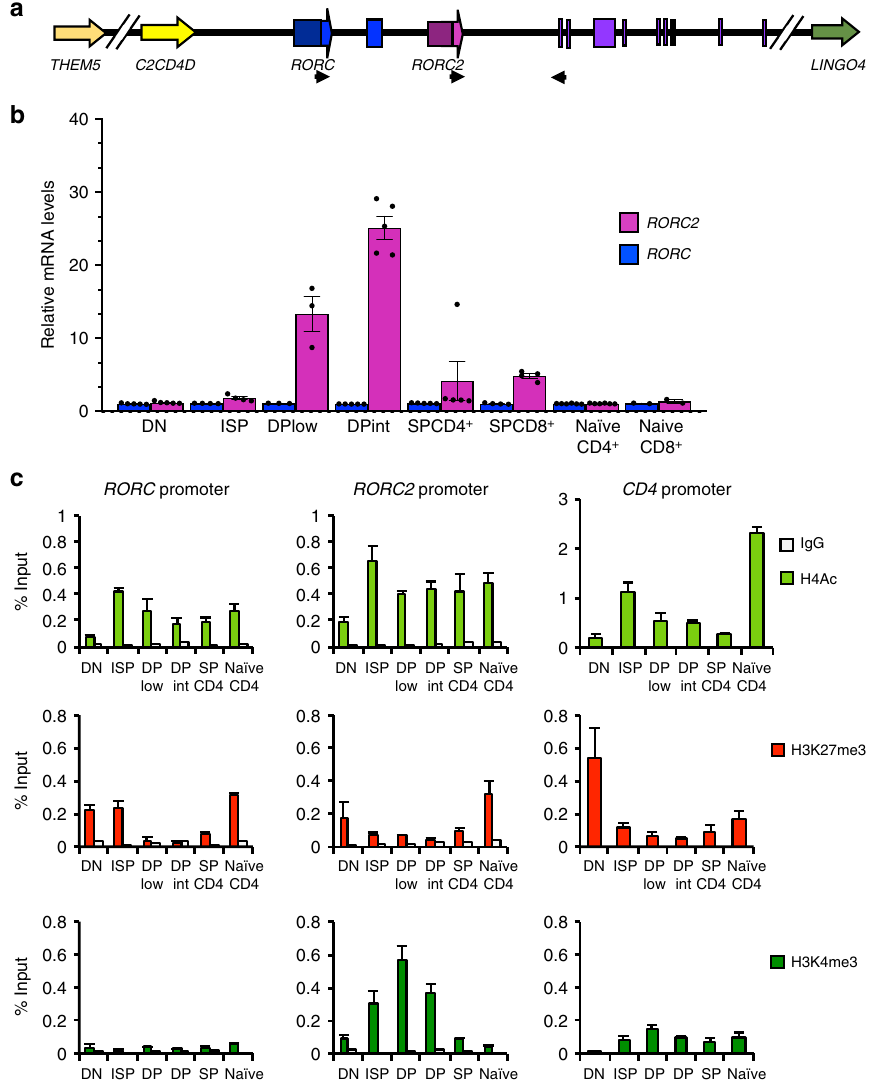
Fig. 1 Remodeling of the RORC promoter during thymocyte development. a Scheme of the human RORC locus: transcription from the RORC promoter generates the ROR γ isoform; the RORC 2 promoter generates the ROR γ t isoform. Blue boxes: unique RORC exons; pink box: unique RORC 2 exon; purple boxes: common exons. Arrows indicate the primers used for RT-qPCR ampli fi cation of the two isoforms. b RORC and RORC 2 expression in sorted thymocyte populations, and naive CD4 + or CD8 + T cells isolated from cord blood was quanti fi ed by microarray. Shown is average and standard deviation of fi ve independent experiments. c Epigenetic modi fi cations at the RORC , RORC 2 and CD4 promoters. ChIP was performed with antibodies against histone 4 acetylation (H4Ac, top); histone 3 lysine 27 trimethylation (H3K27me3, middle) and histone 3 lysine 4 trimethylation (H3K4me3, bottom), on sorted thymocyte populations, and in naive CD4 + T cells from cord blood, followed by RT-qPCR of the RORC promoters and the CD4 promoter (as a quality control). ChIP with an irrelevant IgG antibody tested the speci fi city of binding (white bars). Data are expressed as percent of input and represent average and SD of three replicates. Source data are provided as a Source Data fi